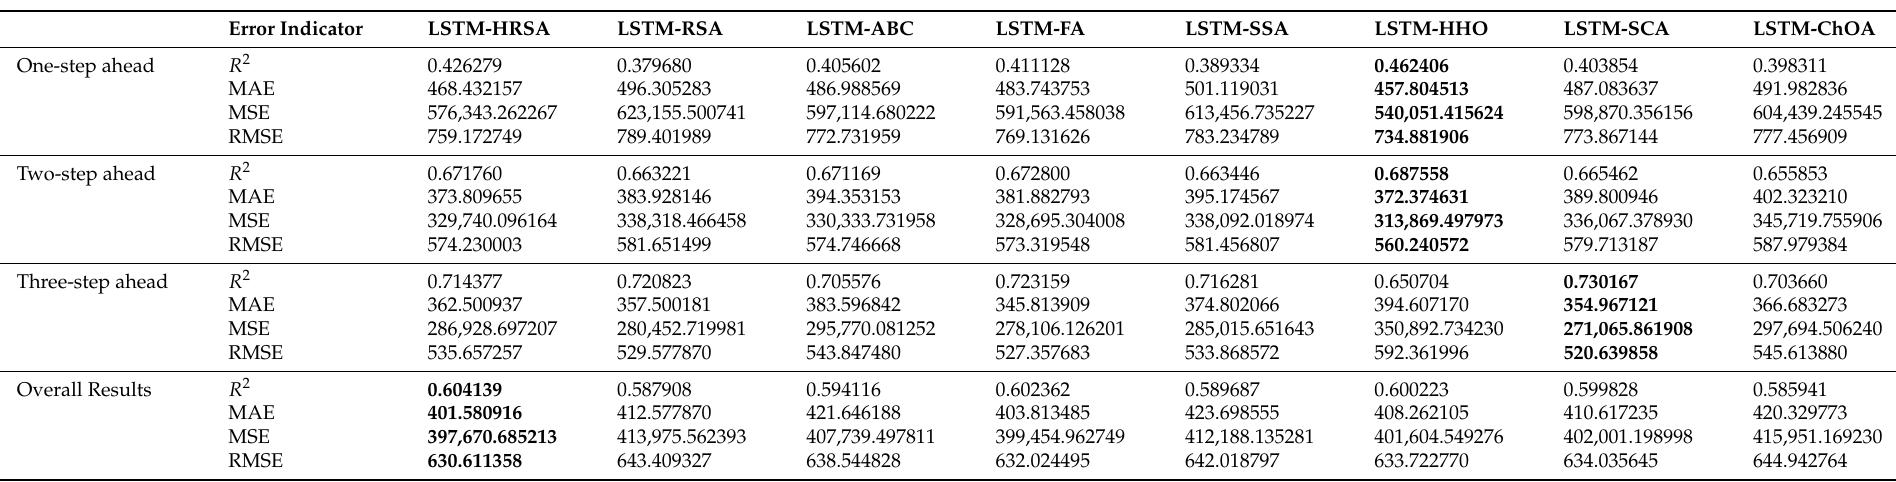
Table 3. Denormalized metrics for one-step, two-step, three-step ahead, and overall predictions for LSTM experiments. The best result in each column is written in